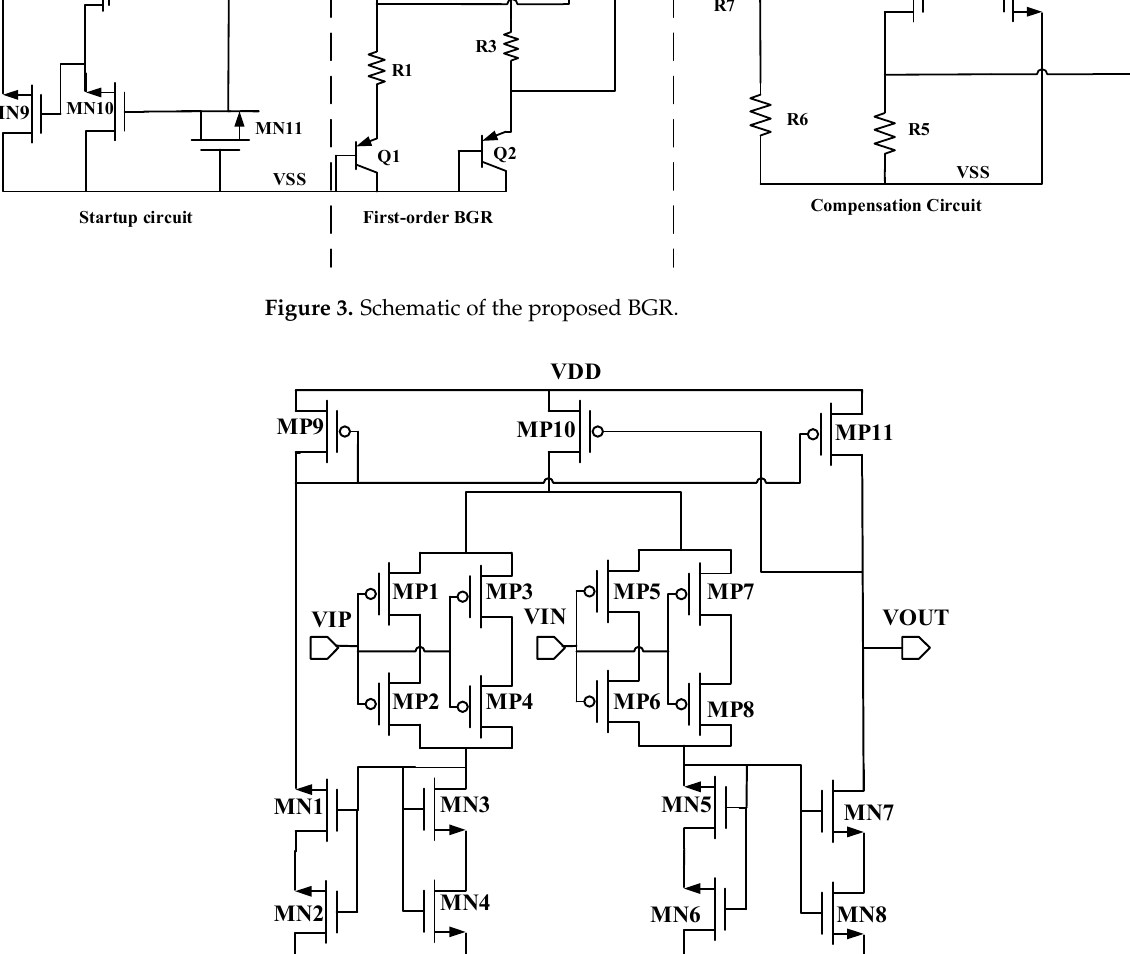
Figure 5. Principle of splitting structure.